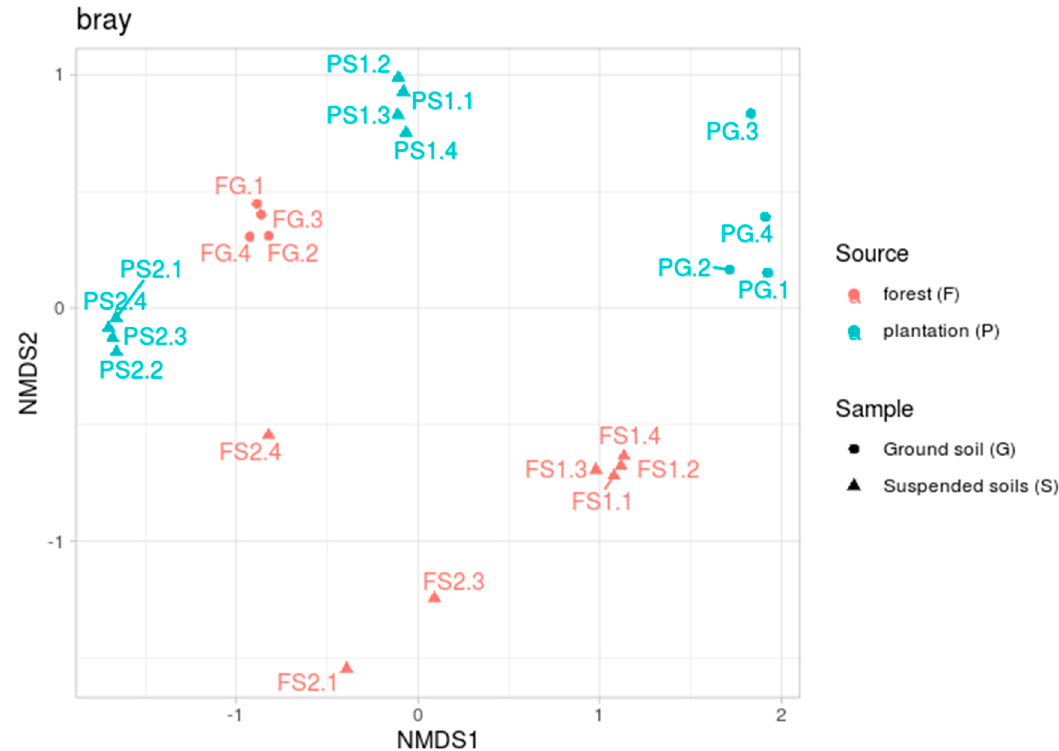
Microorganisms 2021 , 9 , x FOR PEER REVIEW Figure 2. Beta diversity based on the Bray–Curtis dissimilarity metric, NMDS ordination.